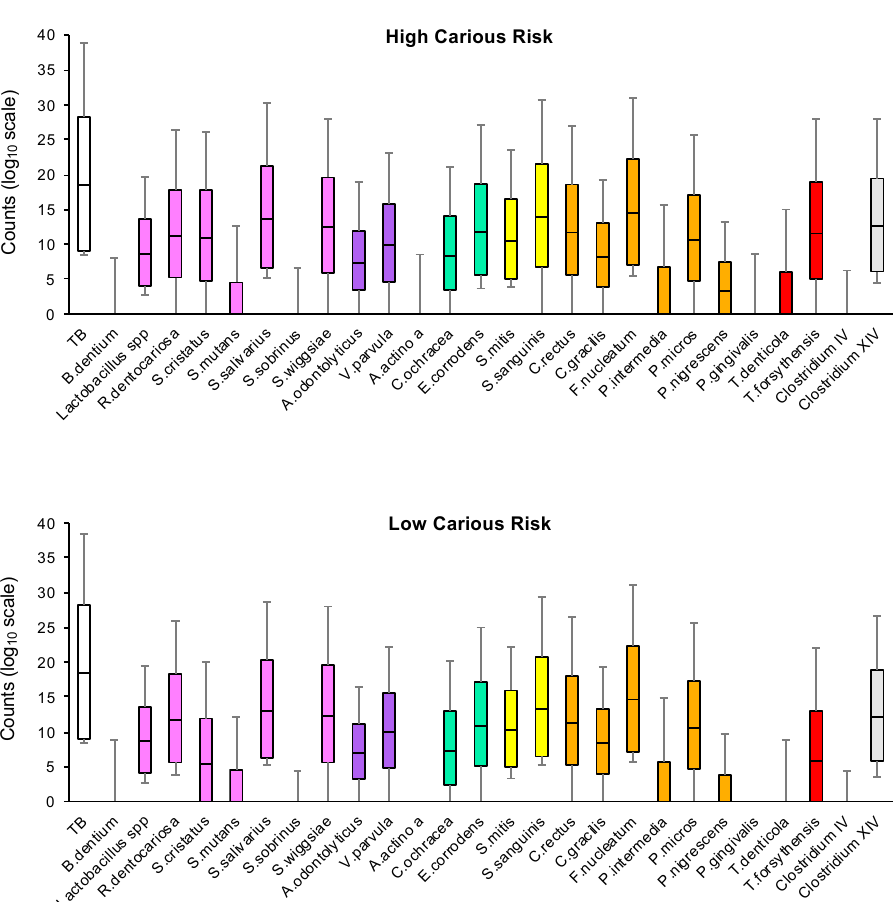
Figure 2. Abundance of bacterial species among the interdental sites in the low carious risk and high carious risk groups. The counts are reported on a log10 scale. Each box represents the first quartile, median quartile, and third quartile, from bottom to top. The first box on the left (TB) corresponds to the total bacteria. The colors in boxes refer to (i) the colors of the Socransky complexes for the purple, green, yellow, orange, and red colors, (ii) cariogenic bacteria for the pink color and (iii) bacteria from the clostridium group for the gray color. TB, total bacterial load.